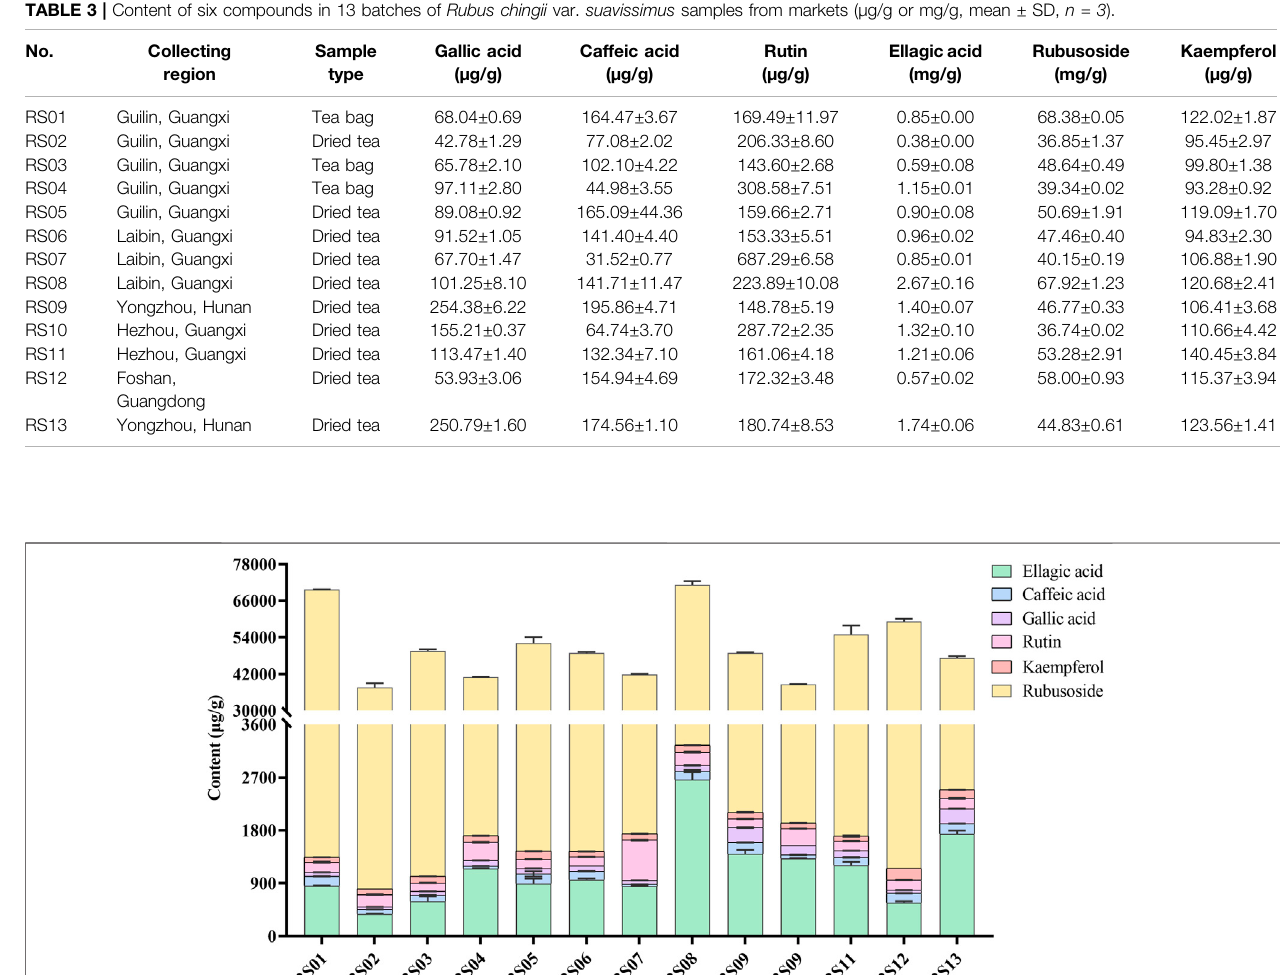
Table S3 . All calibration curves indicated good linearity ( r 2 ≥